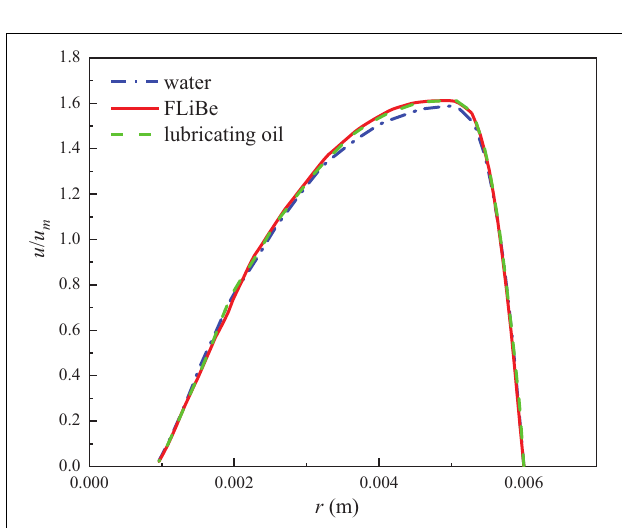
FIGURE 8 | The velocity profile of different fluids in the tube fitted with CCDTT ( y = 3) at l = 0.24 m, Re =